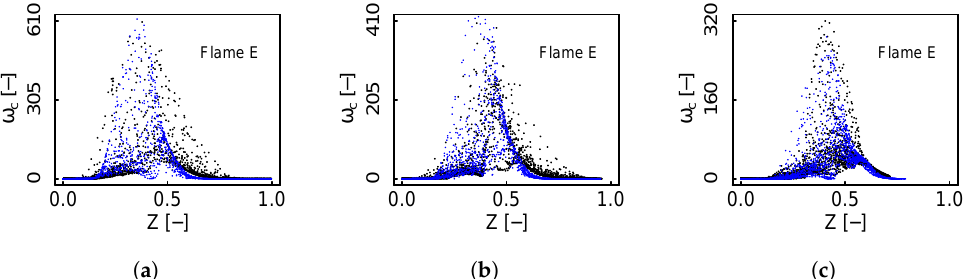
Figure 10. Progress variable chemical source term scattering at different radial sections for flame D. Black color represents non-premixed FTACLES and blue color premixed FTACLES. ( a ) x / d = 7.5; ( b ) x / d = 15; ( c ) x / d = 30.